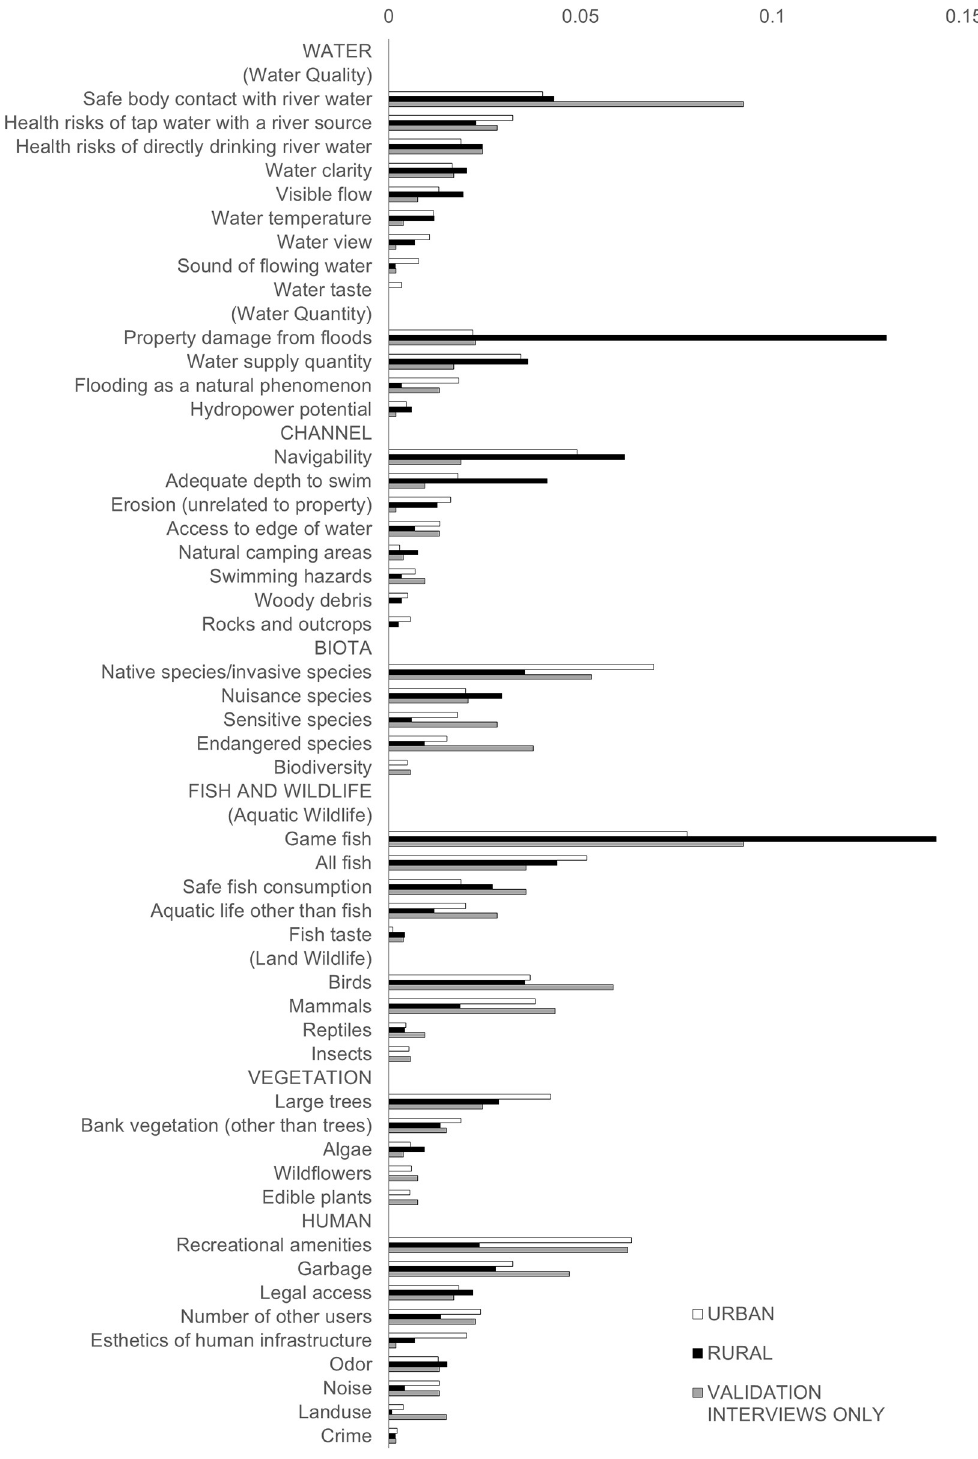
Fig 2. Theme frequency percentages; each population segment weighted equally within the urban or rural class. Validation interviews included in urban and rural results and also broken out as a separate series. Bars sum to 100% for each